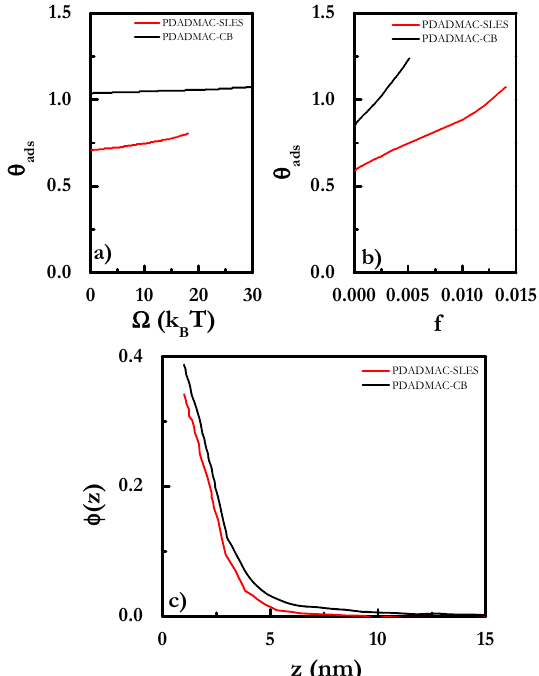
Figure 11. ( a ) Grand potential ( Ω ) dependence of the coverage, θ ads , for different polyelectrolyte– surfactant mixtures. ( b ) f -ratio, which defines the ratio between the number of monomers and the number of surfactant molecules, dependence of the coverage, θ ads , dependences for different polyelectrolyte–surfactant mixtures. ( c ) Volume fraction profiles, φ ( z ), as a function of the distance z from the surface for the different studied